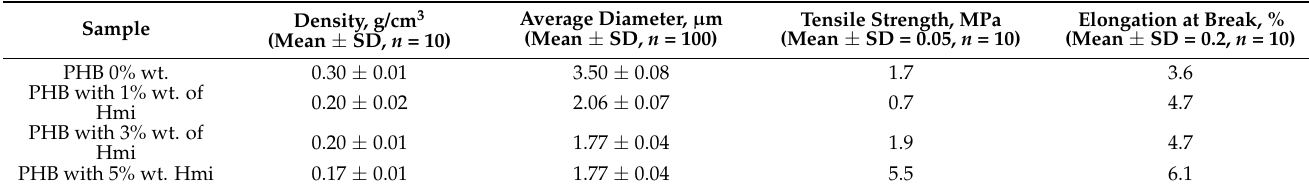
Table 3. Material properties of PHB – Hmi fibers a .